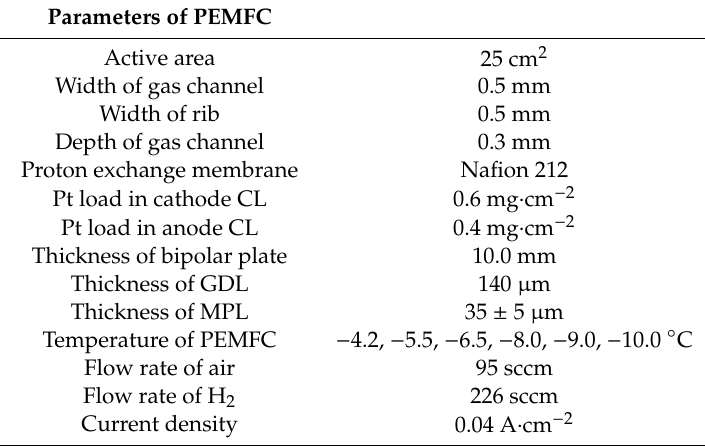
Table 1. Specification of polymer electrolyte membrane fuel cells (PEMFC) and low-temperature start experimental conditions.